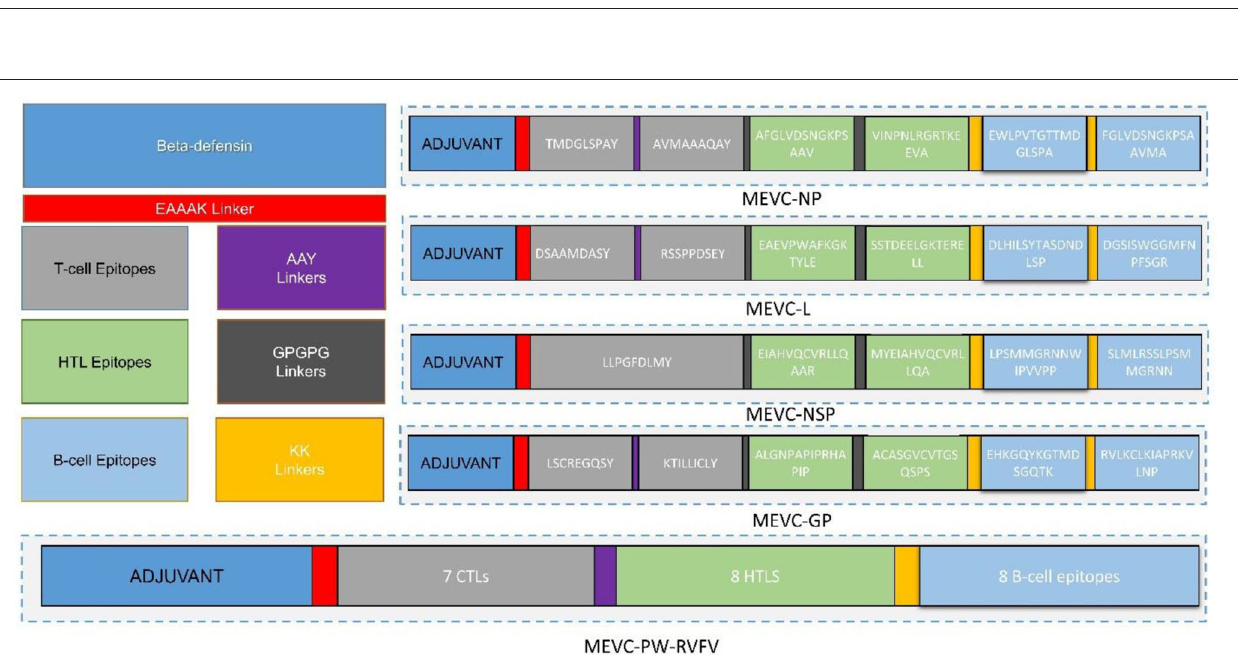
Frontiers in Microbiology |